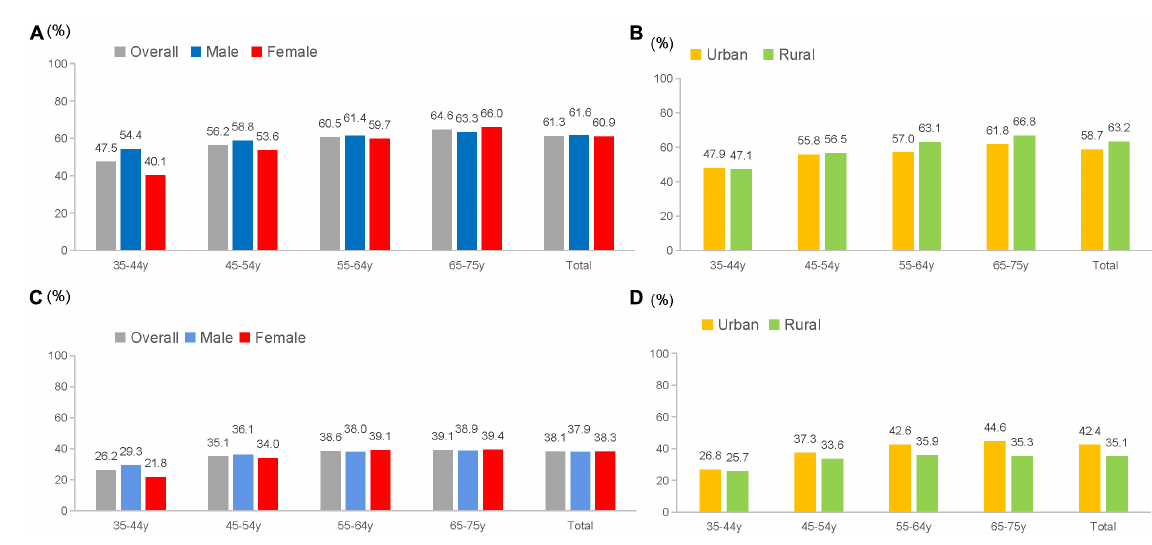
FIGURE1 Prevalence and treatment rate of elevated blood pressure (BP) among stroke survivors. (A) Prevalence of elevated BP stratified by age and sex among stroke survivors. (B) Prevalence of elevated BP stratified by age and urbanity among stroke survivors. (C) Treatment rate of elevated BP stratified by age and sex among stroke survivors with elevated BP. (D) Treatment rate of elevated BP stratified by age and urbanity among stroke survivors with elevated